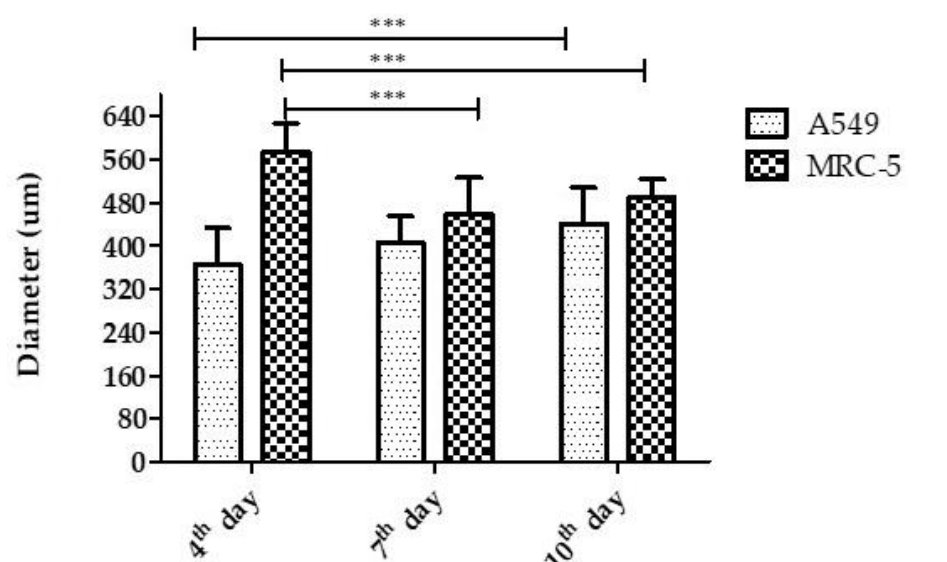
Figure 3. Diameter of the spheroids of the A549 and MRC-5 cell lines on the fourth, seventh, and tenth day of formation. Values expressed as mean and standard deviation. Statistical differences between the A549 cell line from the fourth day in relation to the tenth day and for the MRC-5 cell line from the fourth day in relation to the seventh and tenth day. *** p < 0.001.